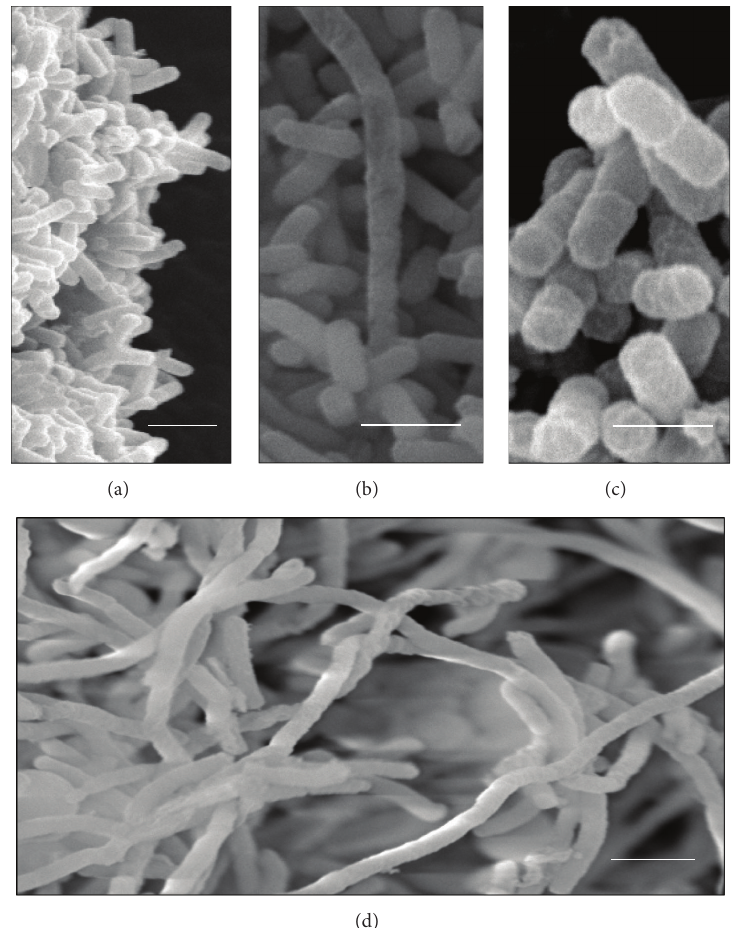
Figure 6: (a–d) Scanning electron micrographs of isolate K3C. (a) Control cells with preserved morphology. (b) Cells subjected to CTX (32 𝜇 gmL −1 ). (c) Cells subjected to CAZ (32 𝜇 g mL −1 ). (d) Cells subjected to ATM (32 𝜇 gmL −1 ). Bars = 2 𝜇 m. CAZ: ceftazidime; CTX: cefotaxime; and ATM: